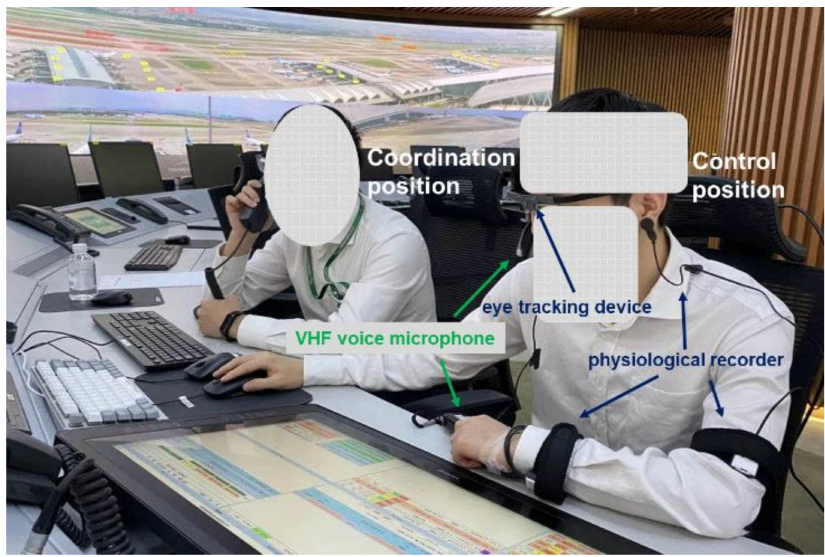
Figure 4. Controllers’ wearing eye-tracking device and physiological recorder for safety performance data acquisition.